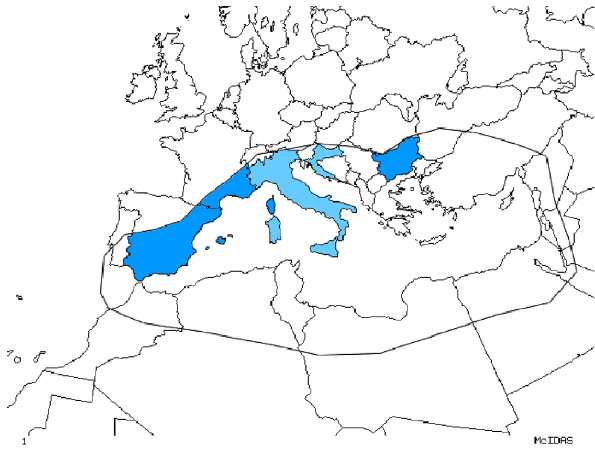
Figure 1. Zones with data in the calendar of high impact weather events included in the MEDEX database. Dark blue corresponds to zones with high density of stations and light blue to zones with low density of